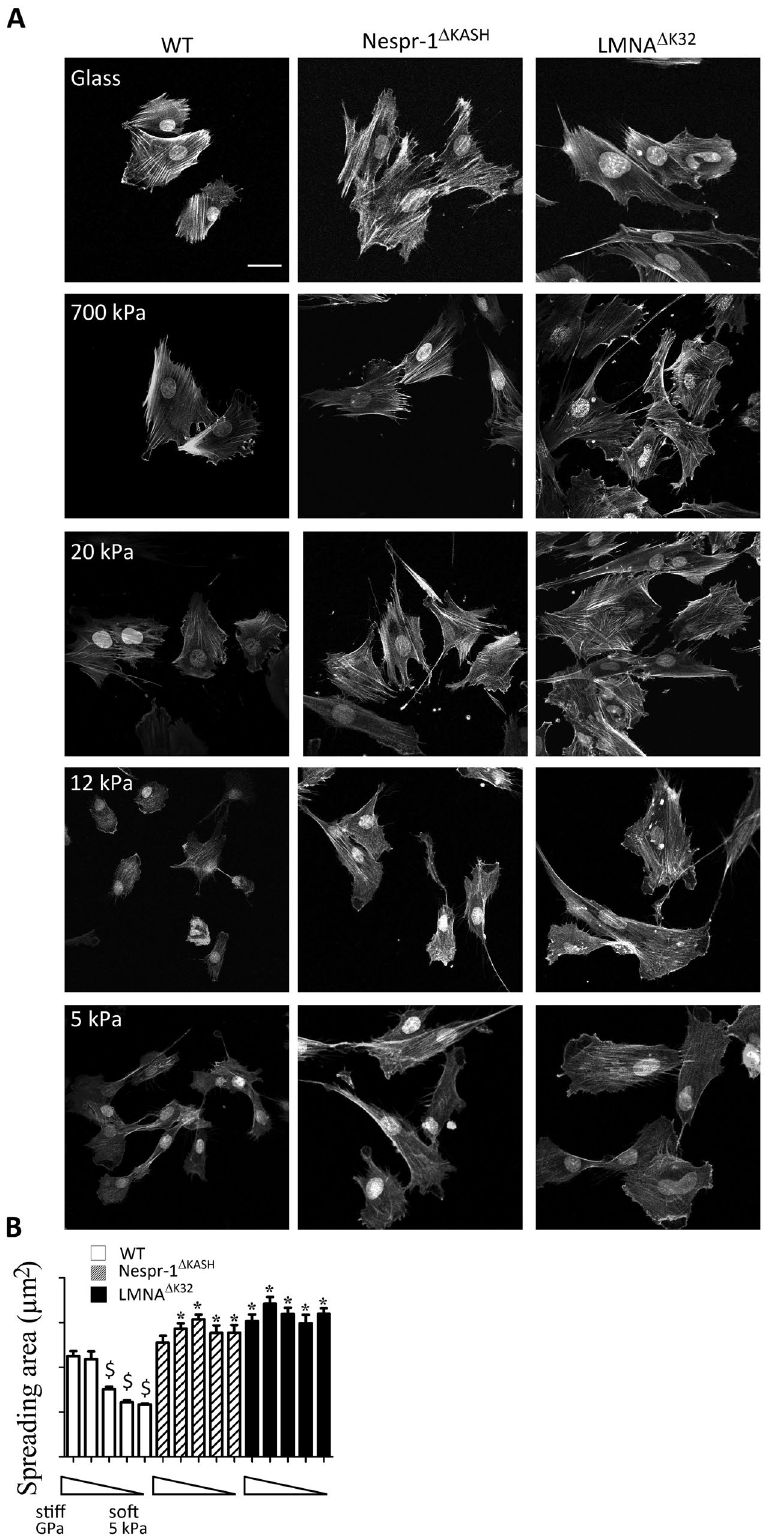
Figure 1. Cell responses to different substrate stiffness. ( A ) Phalloidin staining of the F-actin of fixed WT, Nespr-1 Δ KASH and LMNA Δ K32 myoblasts on fibronectin-coated glass and gel substrates of 700 kPa, 20 kPa, 12 kPa and 5 kPa. Nuclei are stained with DAPI. Scale bar: 40 µ m. ( B ) Projected cell area as a function of substrate stiffness. Analysis was performed on glass and gel substrates of 700 kPa, 20 kPa, 12 kPa, and 5 kPa (each n > 50 cells). Values are means ± SEM; $ p < 0.001 vs corresponding cell line value on glass; * p < 0.001 vs WT value at similar substrate